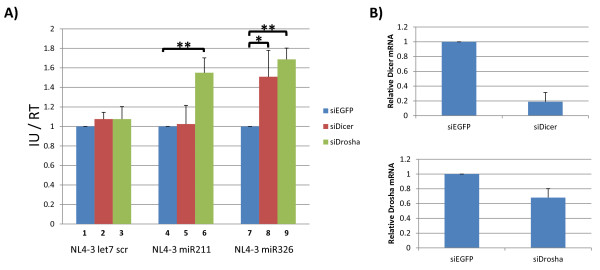
The effect of Dicer and Drosha knockdown on NL4-3 miR326 and NL4-3 miR211 viruses. 293T cells were seeded in a 6-well plate and transfected with 10 pM siRNA against EGFP (control), Dicer, or Drosha. Twenty-four hours post RNA transfection, the cells were transfected with 2 μg of pNL4-3 let7 scr, pNL4-3 miR326 or pNL4-3 miR211. (A) Supernatants were harvested 48 hours post viral transfection and used to determine infectious units as normalized to equal RT values. (B) Total RNA was extracted from transfected 293T cells and used to determine relative expression of Dicer (top panel) and Drosha (lower panel) by quantitative qPCR. Amounts were normalized to GAPDH. Data are shown relative to control (siEGFP) transfection with each virus and are the averages of three replicates. * indicates a p-value < 0.05 and ** indicates a p-value < 0.01.